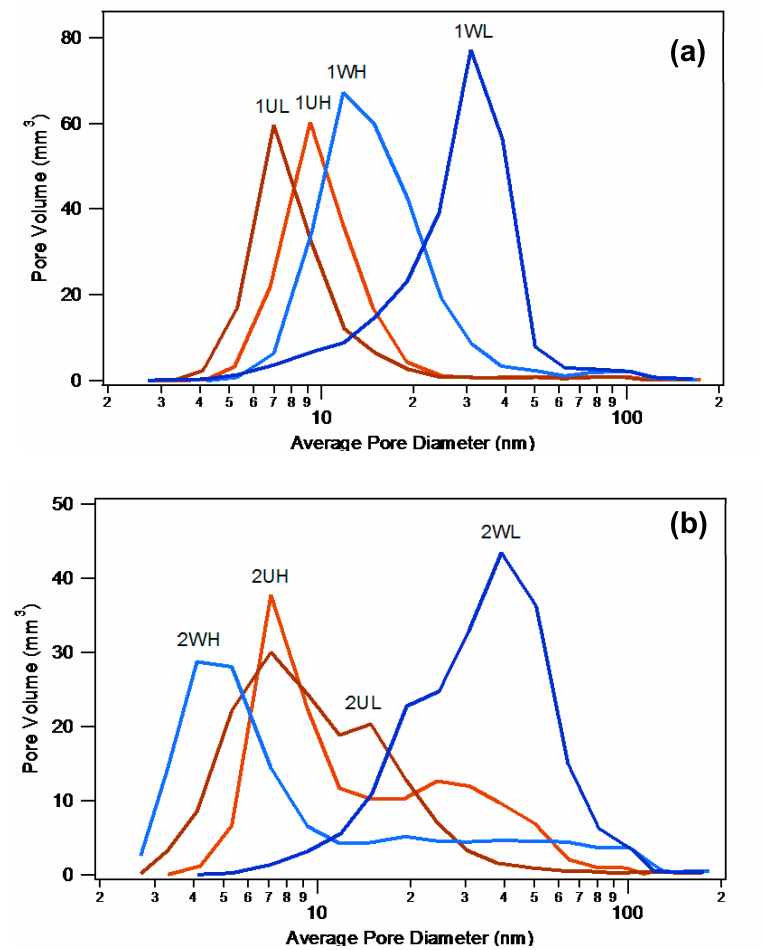
Figure 2. Pore size distributions of ( a ) 1S and ( b ) 2S catalysts after reduction and